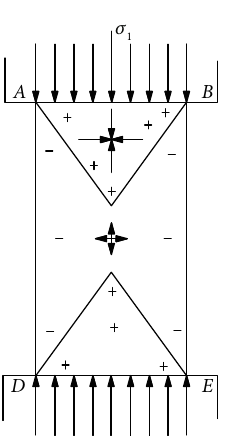
Figure 1: Stress distribution of waste-soil sample in uniaxial compression.